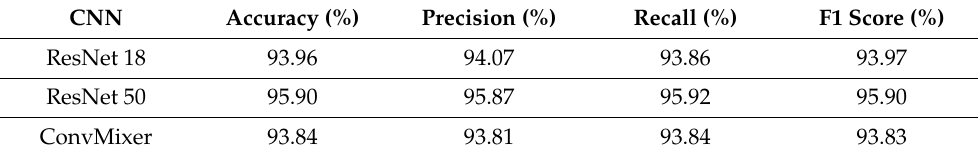
Table 2. Average 10-FCV performance evaluation metrics for 12,800 spectrogram images. Table 2. Average 10 ‐ FCV performance evaluation metrics for 12,800 spectrogram images.